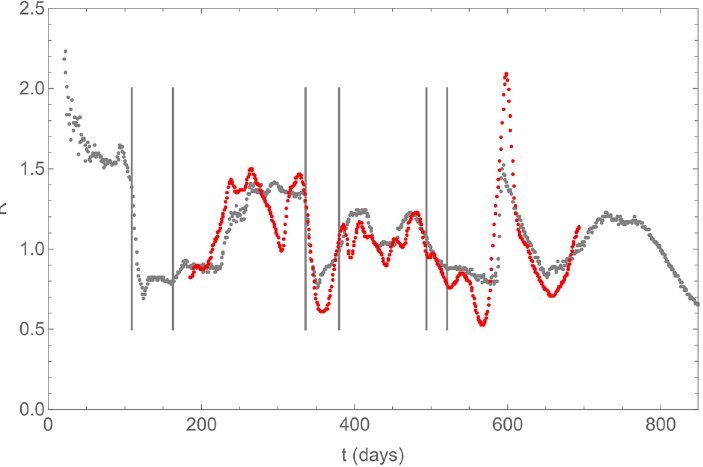
Figure 4. Time evolution of the effective reproduction number R during the COVID-19 pandemic in France. The origin of time, t = 0, corresponds to December 1,2019. The vertical bars correspond to the beginning and end of the three confinement periods in France. The black points correspond to the prediction of our model, while the red points correspond to the data from Ref. 18